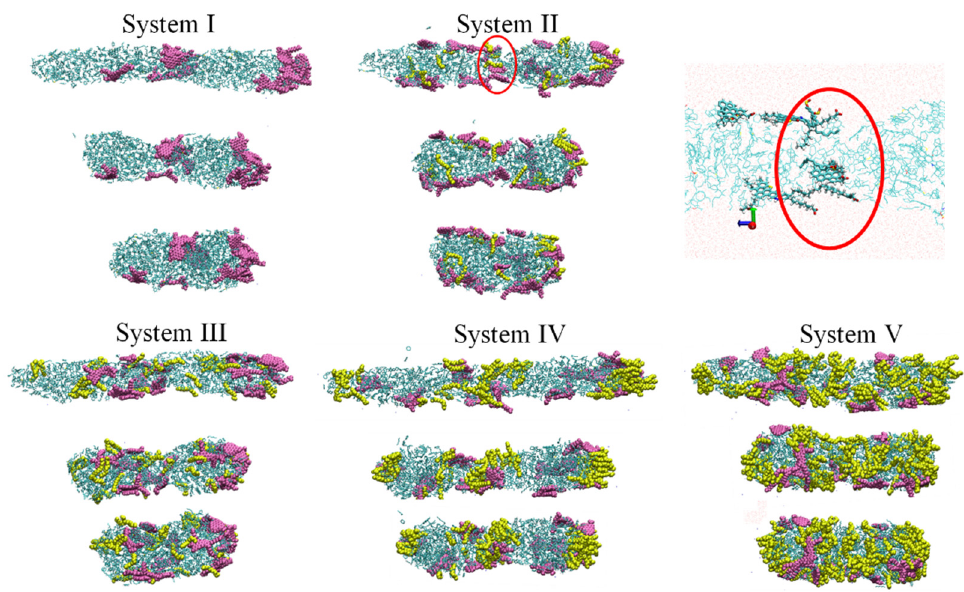
Figure 8. The change in the behaviors of oil droplets during the electric field shut-off period in five systems.